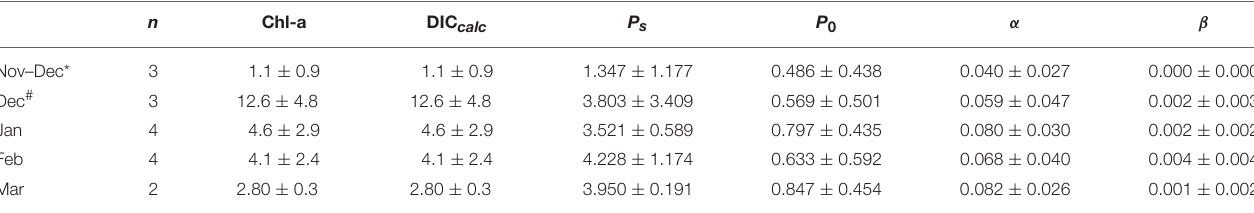
TABLE 1 | Shown below are the mean values ( ± standard deviation) for photosynthetic parameters P s and P 0 (both in µ g C µ g Chl-a − 1 h − 1 ), and α and β [both in µ g C µ g Chl-a − 1 h − 1 ( µ mol quanta m − 2 s − 1 ) − 1 ] as calculated from the 14 C experiments at F max .